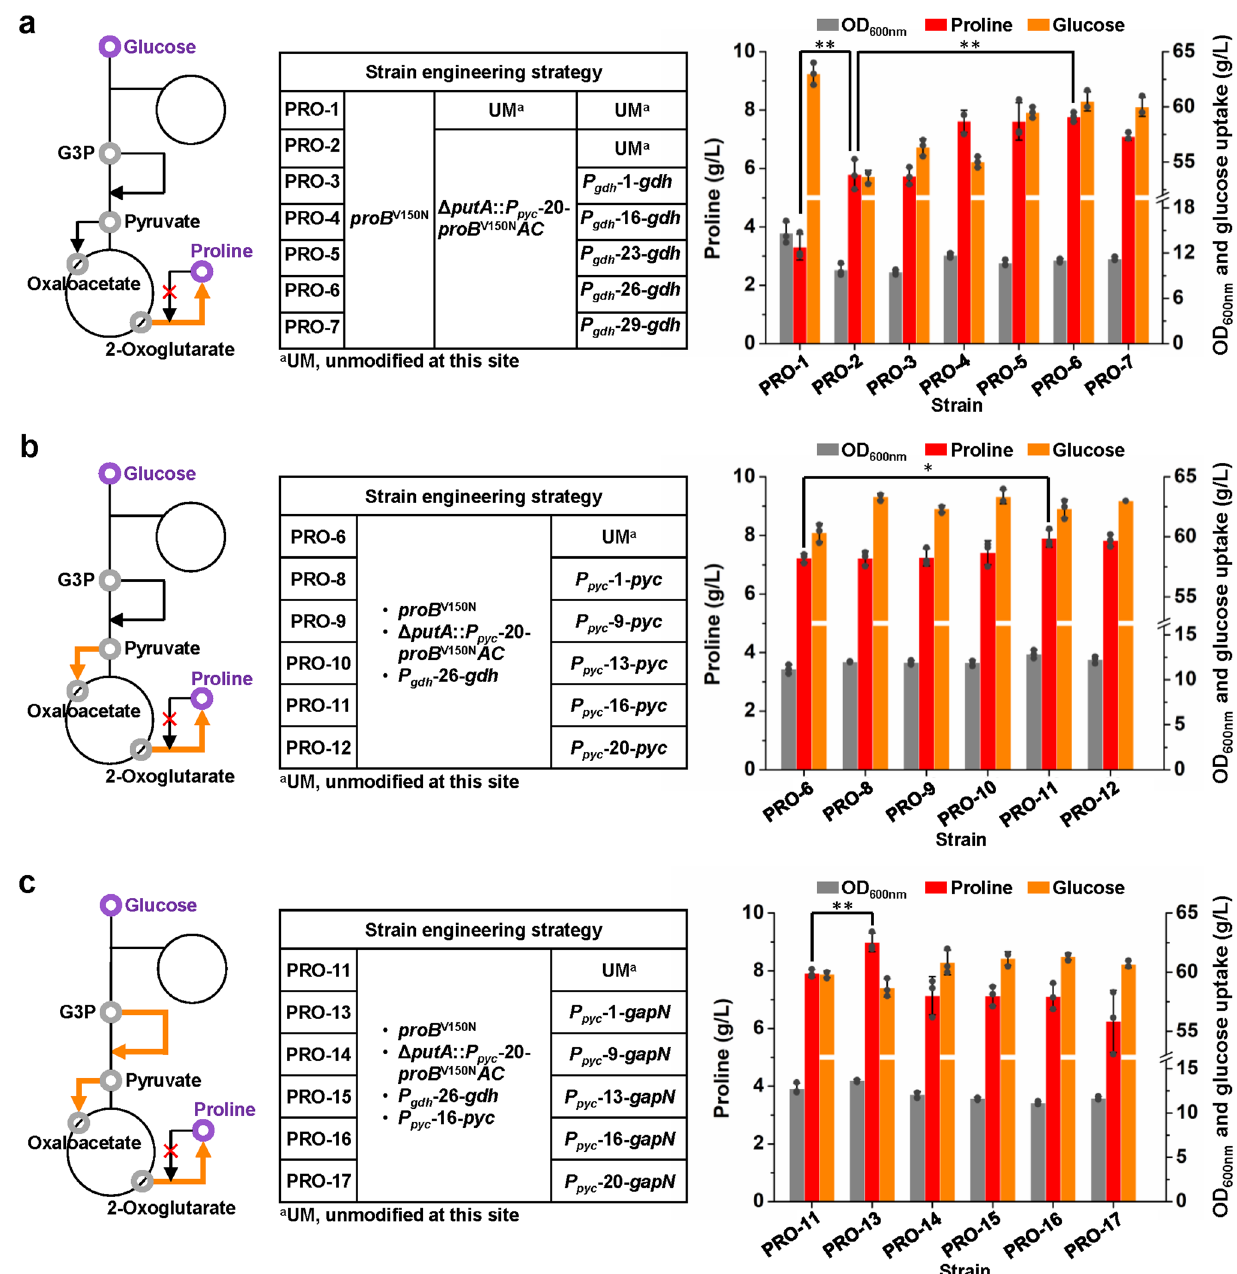
Fig. 5 Enhancing L -proline production by tuning the expression of fl ux-control genes. a Channeling metabolic fl ux into L -proline biosynthesis by overexpressing an arti fi cial proB V150N AC operon and gdh . Strain PRO-1 was constructed by introducing a V150N mutation to the proB gene in the chromosome of wild-type C. glutamicum ATCC 13032. Strain PRO-2 was constructed by inserting an arti fi cial proB V150N AC operon in to the putA gene of strain PRO-1. Strains PRO-3 to PRO-7 were constructed by replacing the wild-type P gdh promoter with different P gdh promoter variants for gdh overexpression in strain PRO-2. L -Proline production was conducted in 24-deep-well plates. Data are presented as mean values + / − SD ( n = 3 independent experiments). ** P = 0.0032 for PRO-1 vs. PRO-2, ** P = 0.0031 for PRO-2 vs. PRO-6, Student ’ s two-tailed t -test. b Strengthening C4 anaplerotic pathway by overexpressing pyc . Strains PRO-8 to PRO-12 were constructed by replacing the wild-type P pyc promoter with different P pyc promoter variants for pyc overexpression in strain PRO-6. L -Proline production was conducted in 24-deep-well plates. Data are presented as mean values + / − SD ( n = 3 independent experiments). * P = 0.0260, Student ’ s two-tailed t -test. c Switching glycolysis cofactor from NADH to NADPH by overexpressing gapN from S. mutans . Strains PRO-13 to PRO-17 were constructed by introducing gapN downstream the cgl2334 gene under the control of different P pyc promoter variants in strain PRO-11. L -Proline production was conducted in 24-deep-well plates. Data are presented as mean values + / − SD ( n = 3 independent experiments). ** P = 0.0059, Student ’ s two-tailed t -test. Source data underlying Fig. 5 are provided as a Source Data fi le.